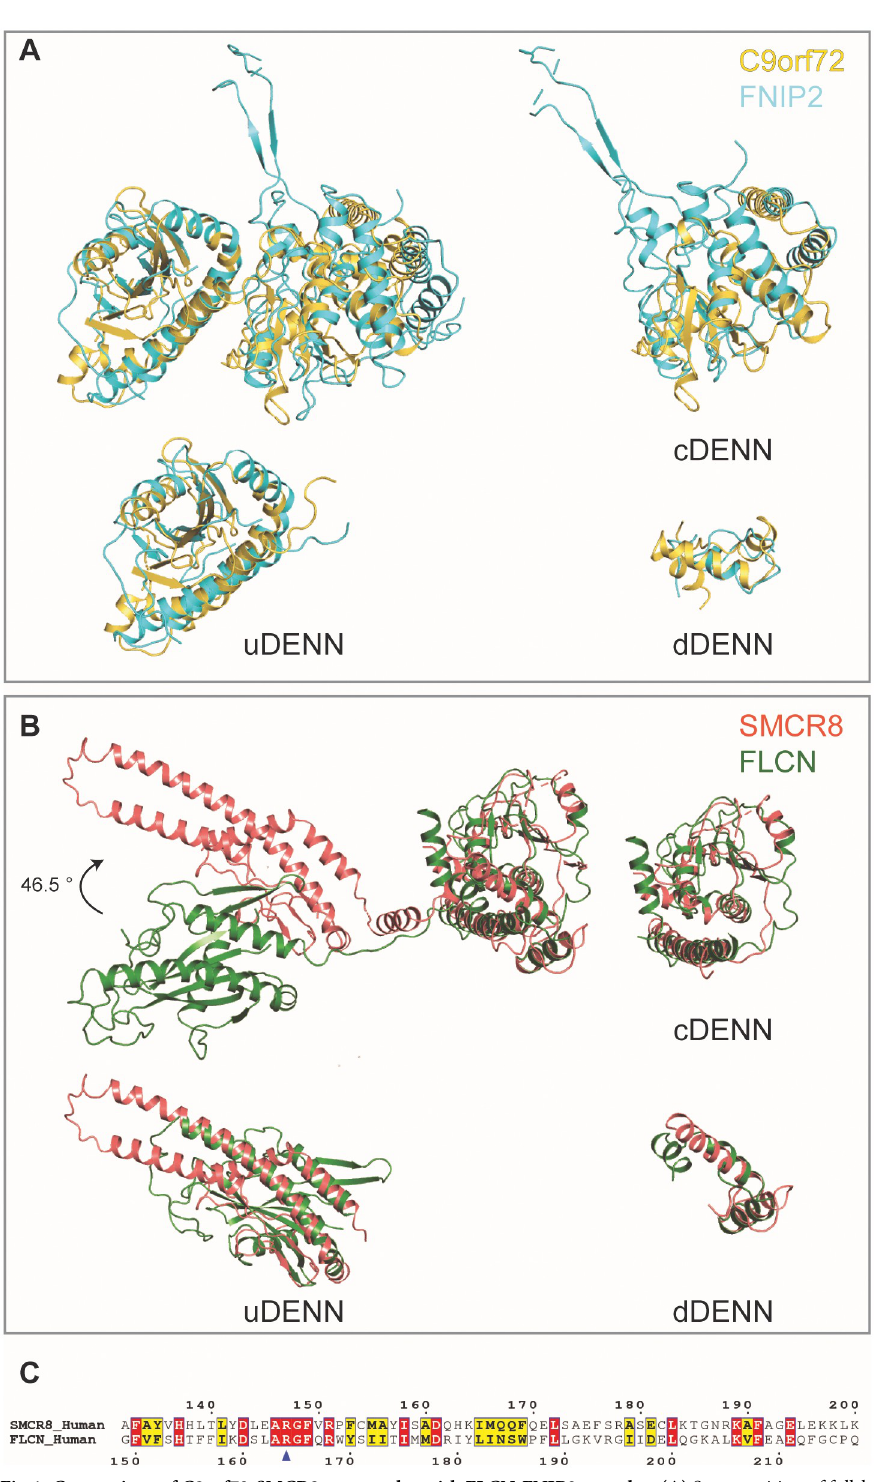
Fig 4. Comparison of C9orf72-SMCR8 N-C complex with FLCN-FNIP2 complex. (A) Superposition of full-length (left top) and the individual uDenn (left bottom), cDenn (right top) and dDenn (right bottom) domains of C9orf72 (yellow orange) protein on the full-length and the individual uDenn, cDenn, and dDenn domains of FNIP2 (cyan) protein (PDB: 6ULG) [28]. (B) Superposition of full-length (left top) and the individual uDenn (left bottom), cDenn (right top), and dDenn (right bottom) domains of SMCR8 N-C (salmon pink) protein on the full-length and